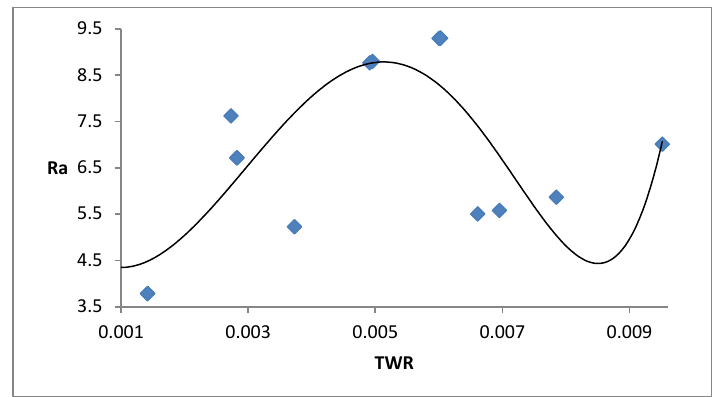
Figure 17. Pareto front between MRR and R a .